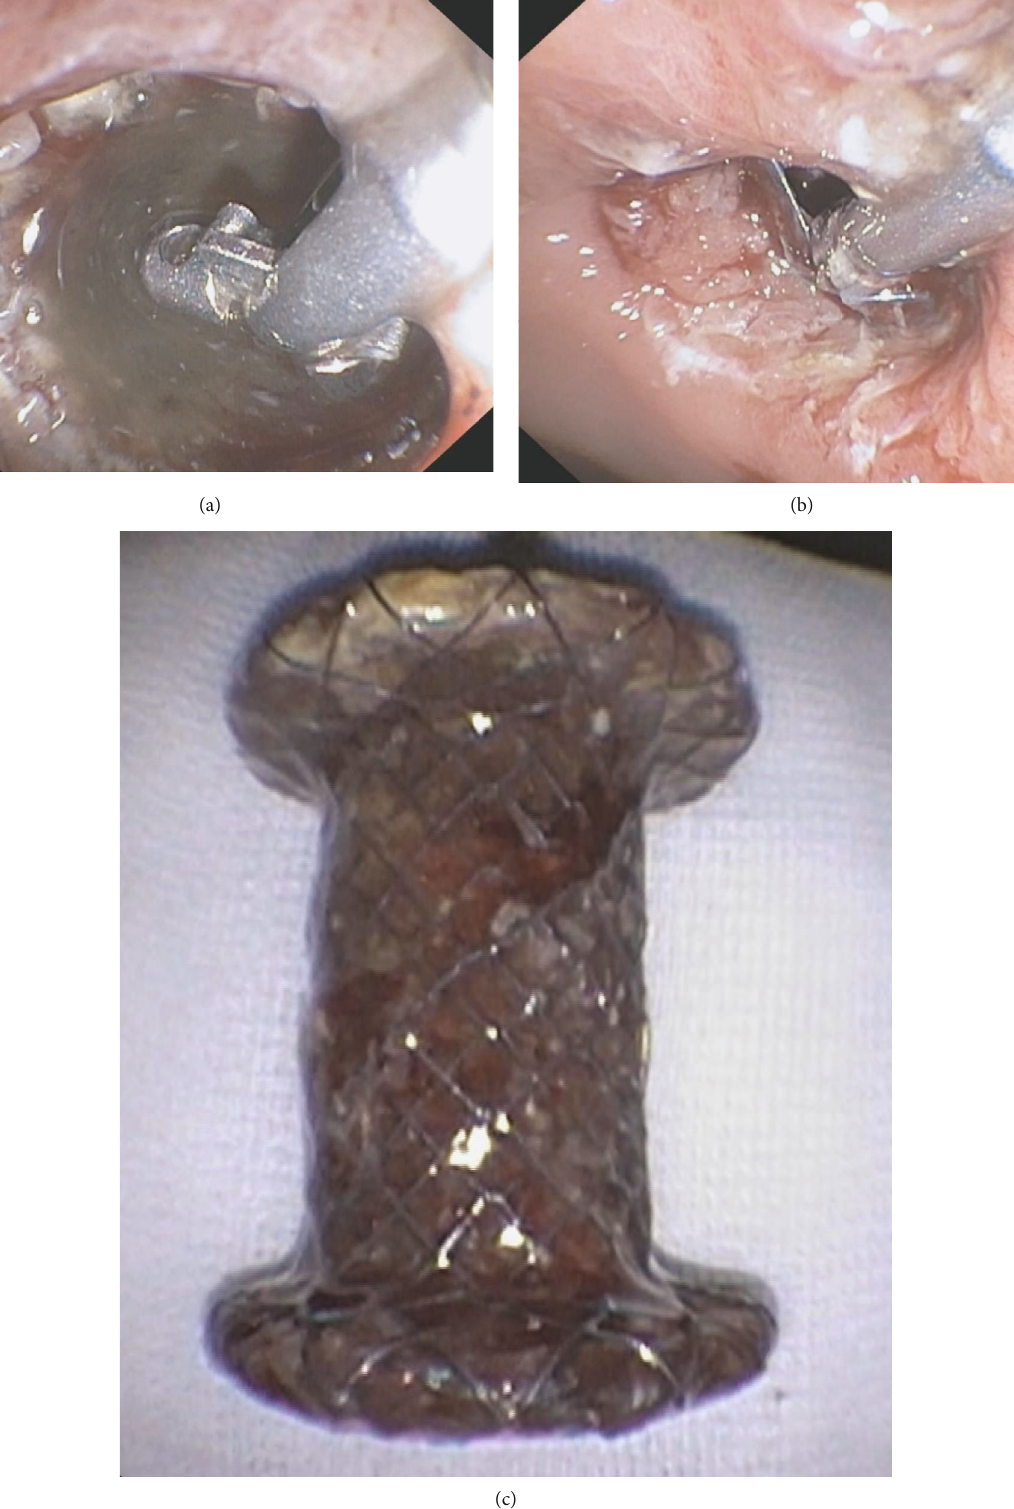
Figure 16: (a – c). Endoscopic treatment of late proximal transmural stent dislocation. (a, b) After the stent was grasped with endoscopic forceps, (c) it could be